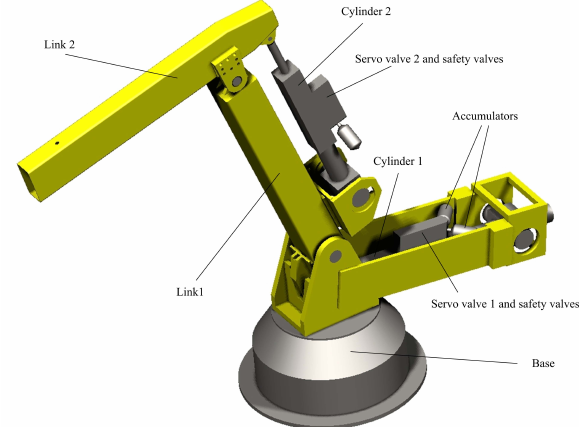
Figure 4: Sketch of the hydraulic driven two link robot, which is used as test